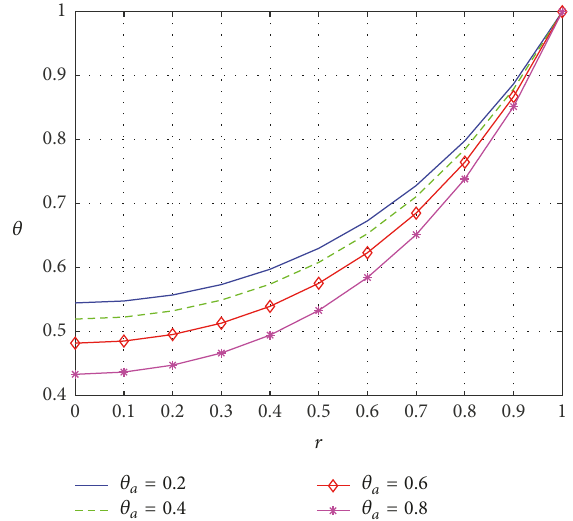
Figure 2: Plot of the temperature with N 𝑟 = 1 , N 𝑐 = 10 , and 𝑟 ∗ = 1/1.75 for 𝑇 = 1 and varied values of 𝜃